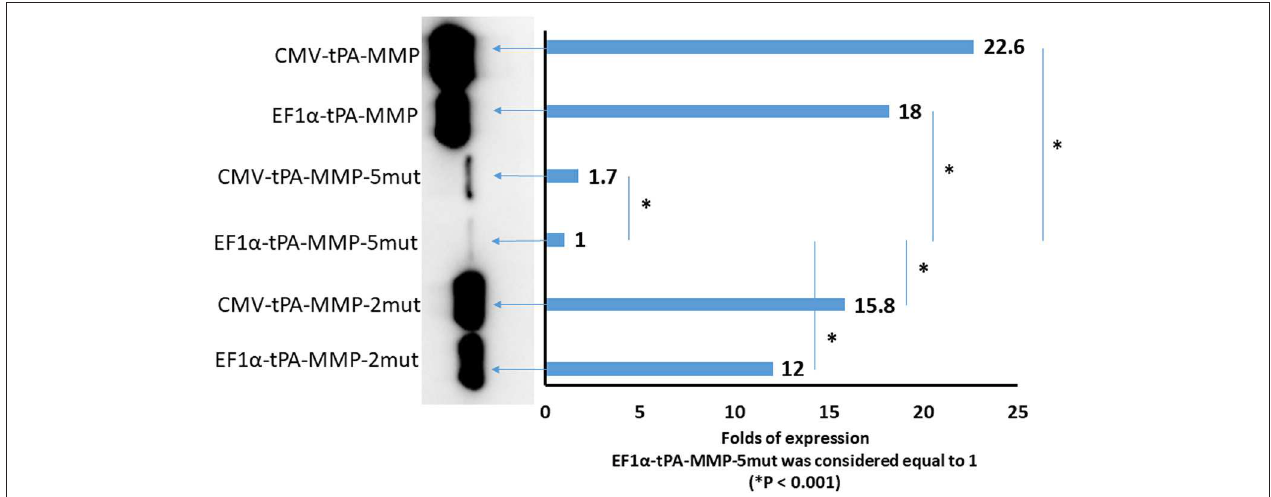
FIGURE 5 | Quantitative Western immunoblot of serum-free medium containing secreted tPA-MMP-5mut, tPA-MMP-2mut, and tPA-MMP from pCMV-tPA-MMP-5mut, pEF1 α -tPA-MMP-5mut, pCMV-tPA-MMP-2mut, pEF1 α -tPA-MMP-2mut, pCMV-tPA-MMP, and pEF1 α -tPA-MMP transfected HEK 293T cells at 48h post transfection. Each lane was loaded with 15 µ l of serum-free medium supernatant. The same number of HEK 293T cells were transfected with the same amount of each DNA plasmid with the same efficiency of transfection (100%), as determined by co-transfection with pEGFP-C1. Band intensity was quantified using densitometry (ChemiDoc; MPIMAGING SYSTEM, LAB SOFTWARE, BioRad), and displayed using a bar graph. Data were normalized as folds of increased secretion, where pEF1 α -tPA-MMP-5mut signal was considered equal to 1. The experiment was repeated three times, and statistical significance ( P < 0.001) was assessed using a Student’s t -test and one-way ANOVA.